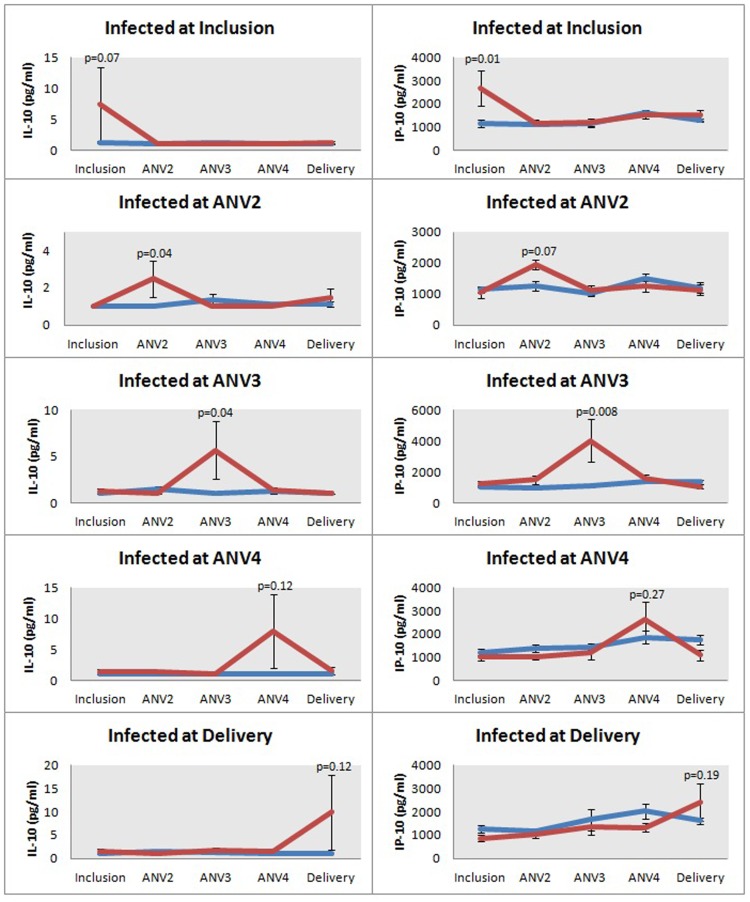
Longitudinal assessment of IL-10 and IP-10 during pregnancy.All women that were infected during their pregnancy were grouped according to the time point when the women were infected. For each group of infected women, samples from the negative control women at the same occasion were grouped together in the same graph. The three antenatal visits (ANV) were at gestational ages 26 (ANV2), 30 (ANV3), and 36 (ANV4). At inclusion: uninfected (n = 24), infected (n = 13); at ANV2: uninfected (n = 13), infected (n = 7); at ANV3: uninfected (n = 15), infected (n = 8); at ANV4: uninfected (n = 13), infected (n = 7); at Delivery: uninfected (n = 14), infected (n = 7). The red lines illustrate mean values for the infected women and the blue line illustrates the mean values for the uninfected control women. The statistical significance of differences in the concentrations between infected and uninfected women at the different time-points is illustrated.